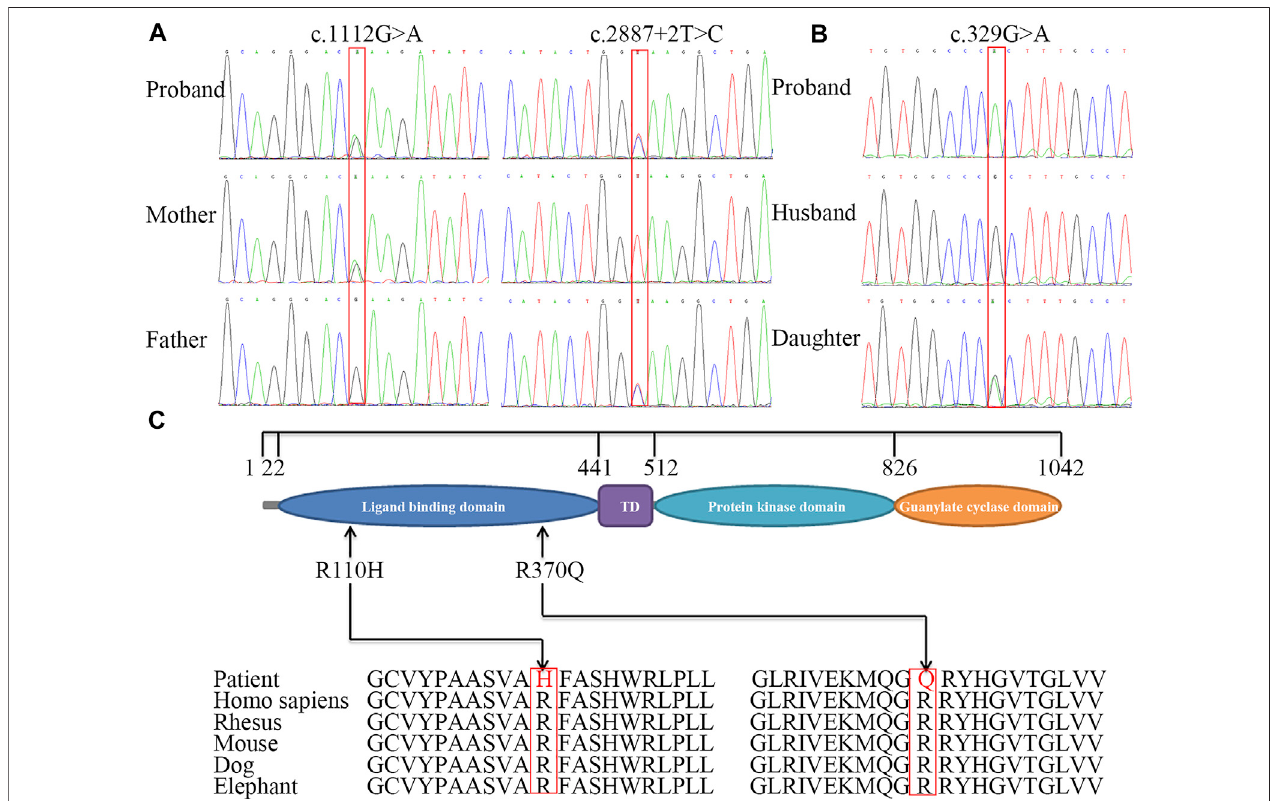
FIGURE 3 | Sequence analysis of NPR2 gene and conservation analysis of missense mutations. Partial DNA sequence of three variants including c.1112G > A and splicedonor sitevariant identi fi edinfamily 1, mother and fatherarecarriers forabove mentionedmutation (A) ,and missense homozygousmutationc.329G > Aidenti fi ed inpatient2,herdaughteriscarrierforthesamemutation (B) .Thestructureof NPR2 andthepositionofmutations (C) .Thedifferentgeometricshapeswithdifferentcolors on amino acid (aa) sequence denote the four distinct functional regions respectively. Its amino acid substitution in two patients were both highly conservative